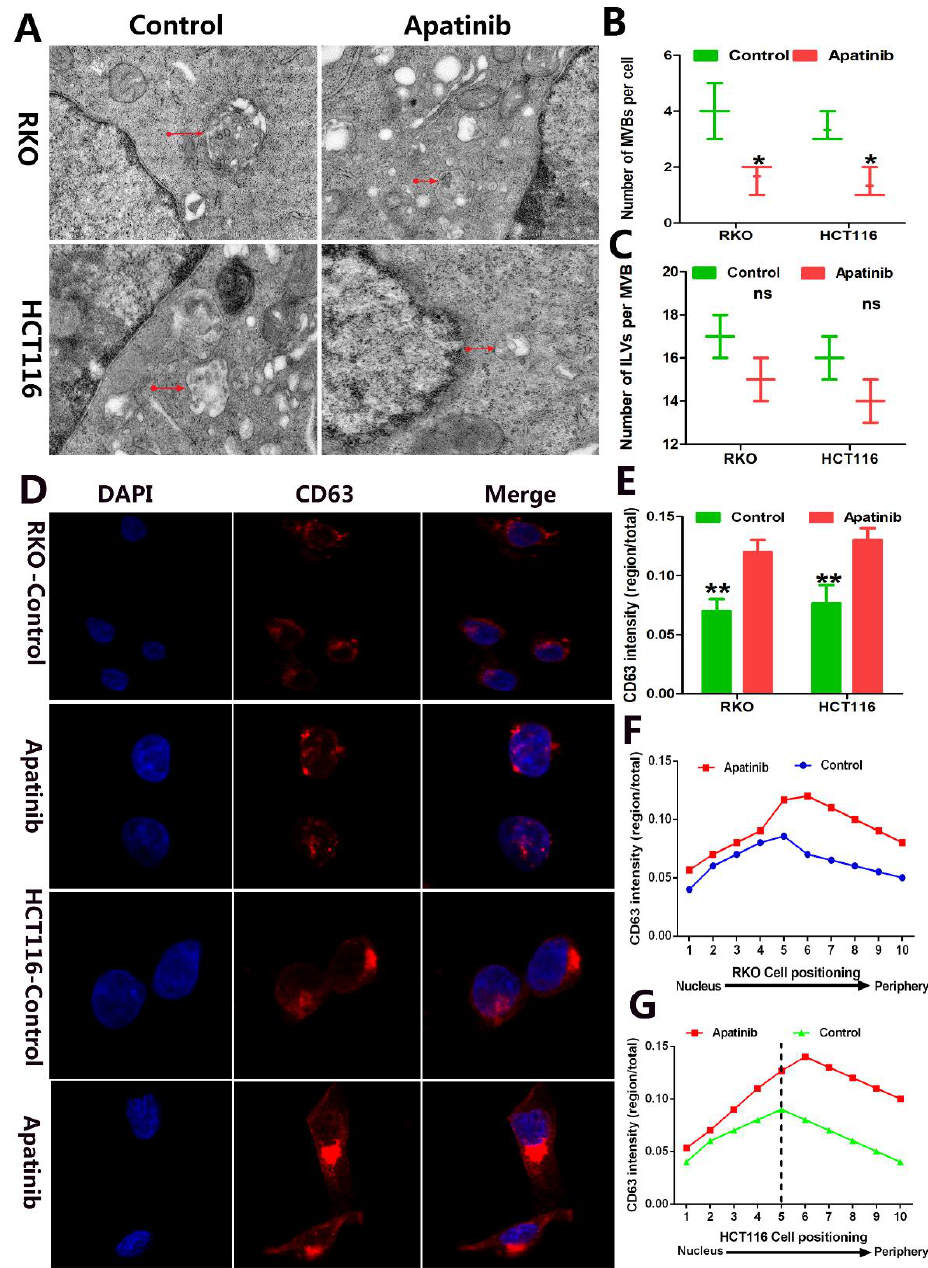
Figure 5. Apatinib inhibited the transport of MVBs towards the plasma membrane in CRC cells. ( A ) Representative electron microscopic images of control and apatinib treatment cells. ( B ) The number of MVBs per cell profile. ( C ) The number of ILVs per MVB. ( D ) Immunofluorescence of the control and apatinib-treated cells stained with CD63. ( E ) Quantification of CD63 + vesicle distribution within the cell. ( F , G ) Quantification of CD63 intensity within the perinuclear region of RKO and HCT116 cells. * p < 0.05, ** p < 0.01.